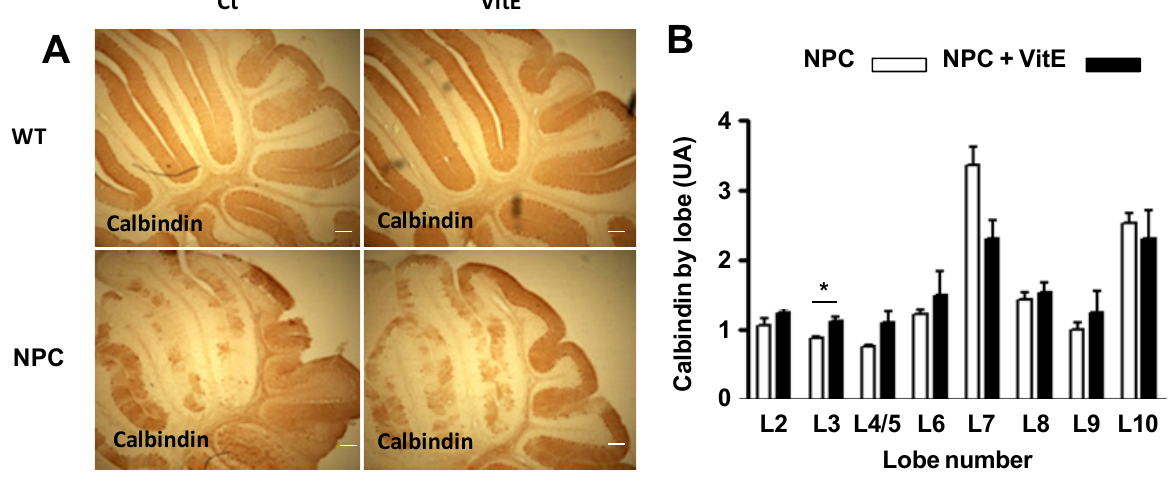
Figure 2. Vitamin E treatment improves Purkinje cell survival in the cerebellum of NPC mice. Wild-type (WT) and NPC mice received vitamin E (Vit E) (2000 IU/Kg DL-Alpha Tocopherol Acetate) or control (Ct) diets starting at p28. Cerebella from Ct- and Vit E-treated WT and NPC mice were analyzed at 7 weeks of age. ( A ) Calbindin was analyzed by immunohistochemistry. Scale bar, 100 μ m; ( B ) A quantification of calbindin- immunoreactive Purkinje cell bodies in cerebellar sections ( n = 3 mice/group) is shown; white and black bars are shown for Ct-and Vit E-treated NPC mice. Results are means ± SE. * p = 0.0091; ( C ) α -TOH content was measured by HPLC in brain